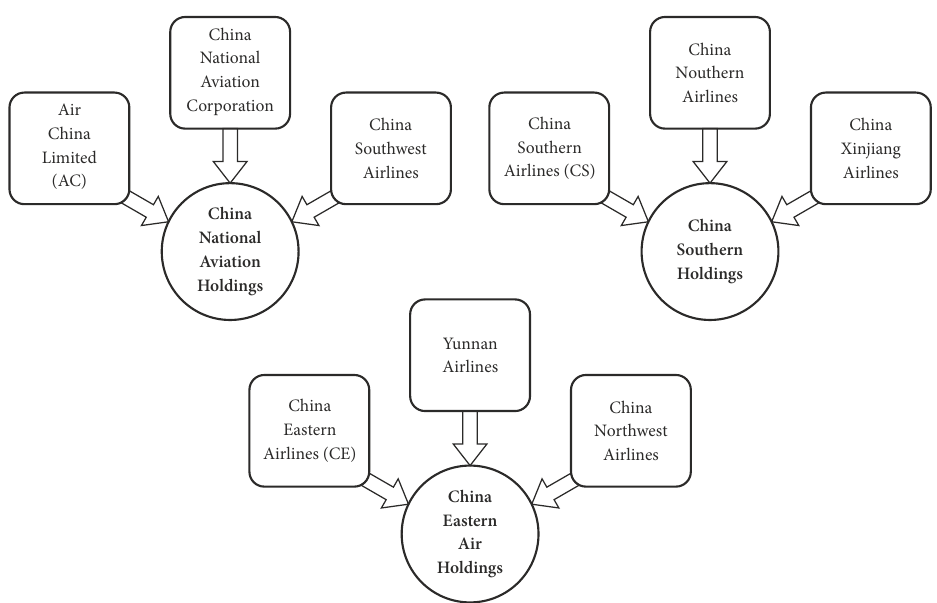
Figure 2. Nine smaller regional carriers forming the Big Three – China National Aviation Holdings, China Southern Holdings and China Eastern Air